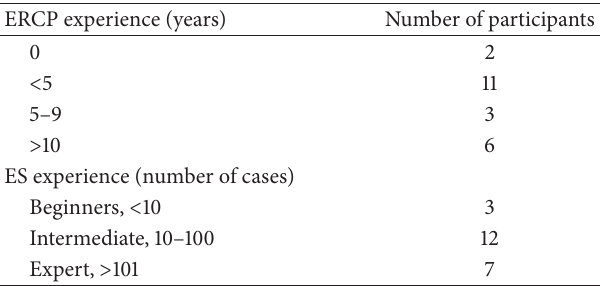
Table 2: ERCP and ES experience of the participants of the hands- on